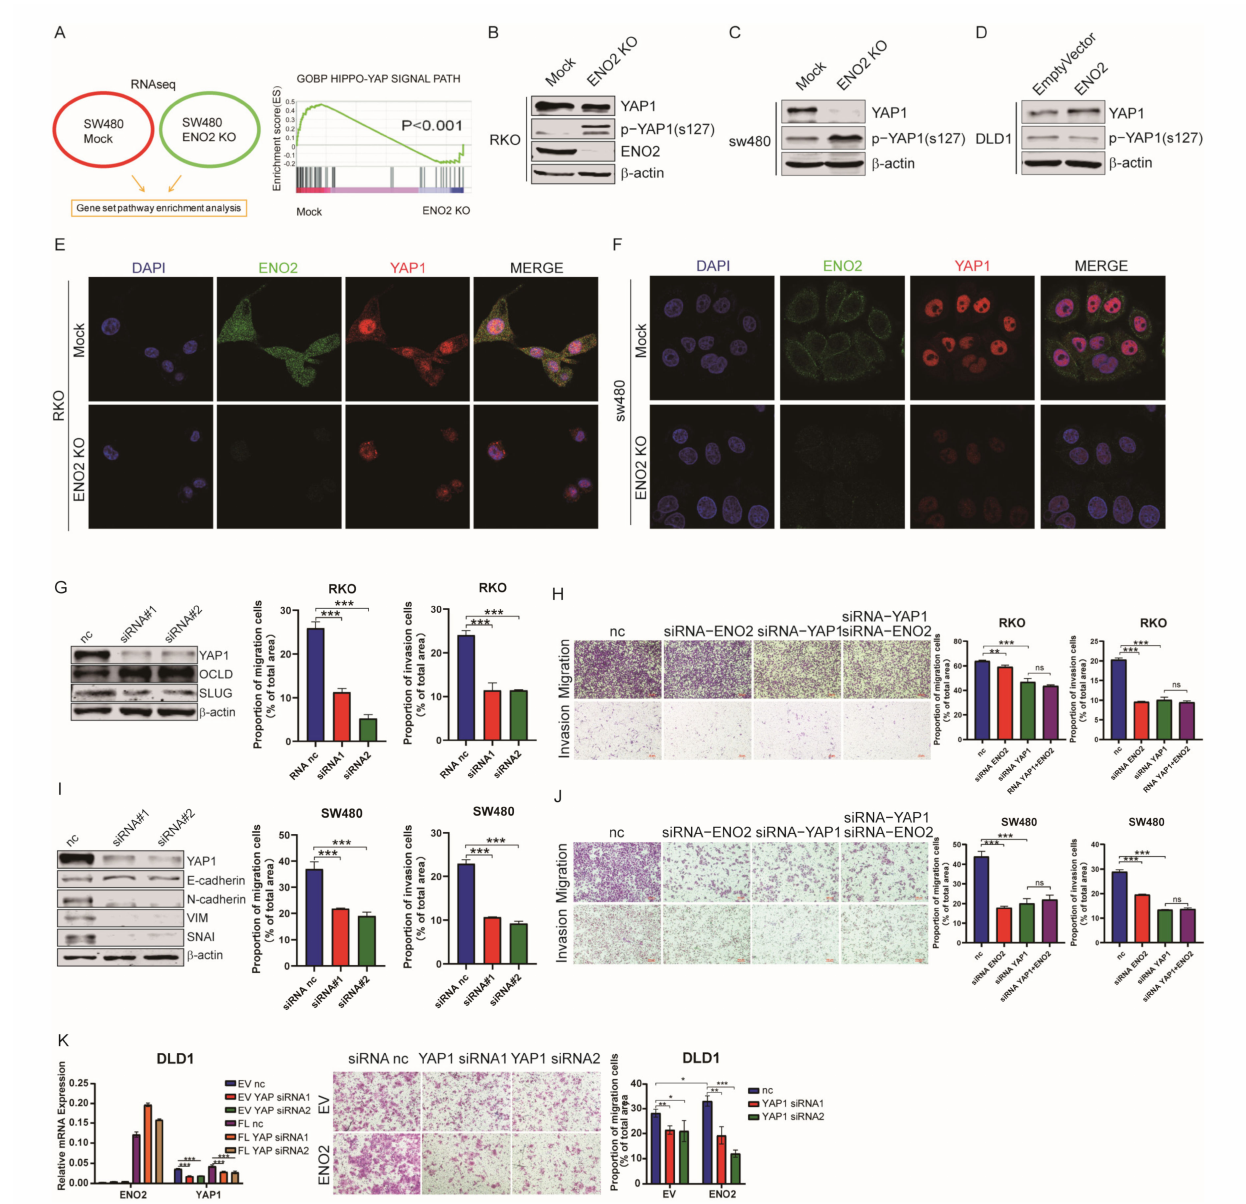
Figure 5. ENO2 induced YAP1 activation by suppressing its phosphorylation. ( A ): ENO2 stimulates the Hippo pathway in SW480 cells. ( B – D ): The phosphorylation of YAP1 Ser127 and the degradation of YAP1 were detected by Western blot after ENO2 knockdown. ( E , F ): IF assay showing ENO2 and YAP1 expression. Scale bar = 10 µ m. YAP1 is stained red, ENO2 is stained green, and the nucleus is stained blue (DAPI). ( G , H ): Identification of YAP1 and ENO2 knockdown in RKO cells ( G ). Migration and invasion of RKO cells with YAP1 and ENO2 knockdown ( H ). ( I , J ): Identification of YAP1 and ENO2 knockdown in SW480 cells ( I ). Migration and invasion of SW480 cells with YAP1 and ENO2 knockdown ( J ). ( K ): The migration of DLD1 cells overexpressing ENO2 with YAP1 knockdown. Data are shown as the mean ± SD. * p < 0.05, ** p < 0.01, *** p < 0.001. ns: non